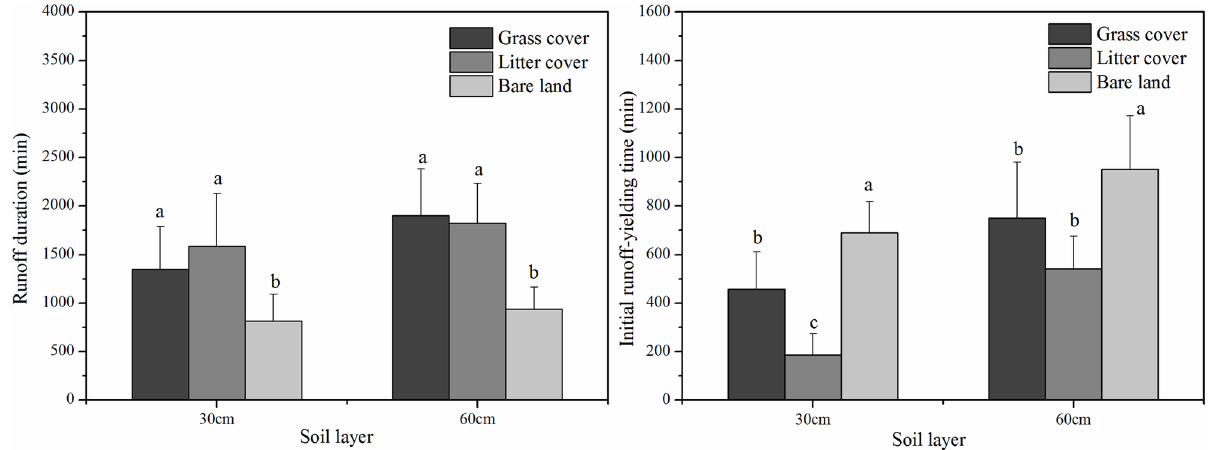
Fig 7. Duration and initial runoff yield time of subsurface flow generation under three land cover